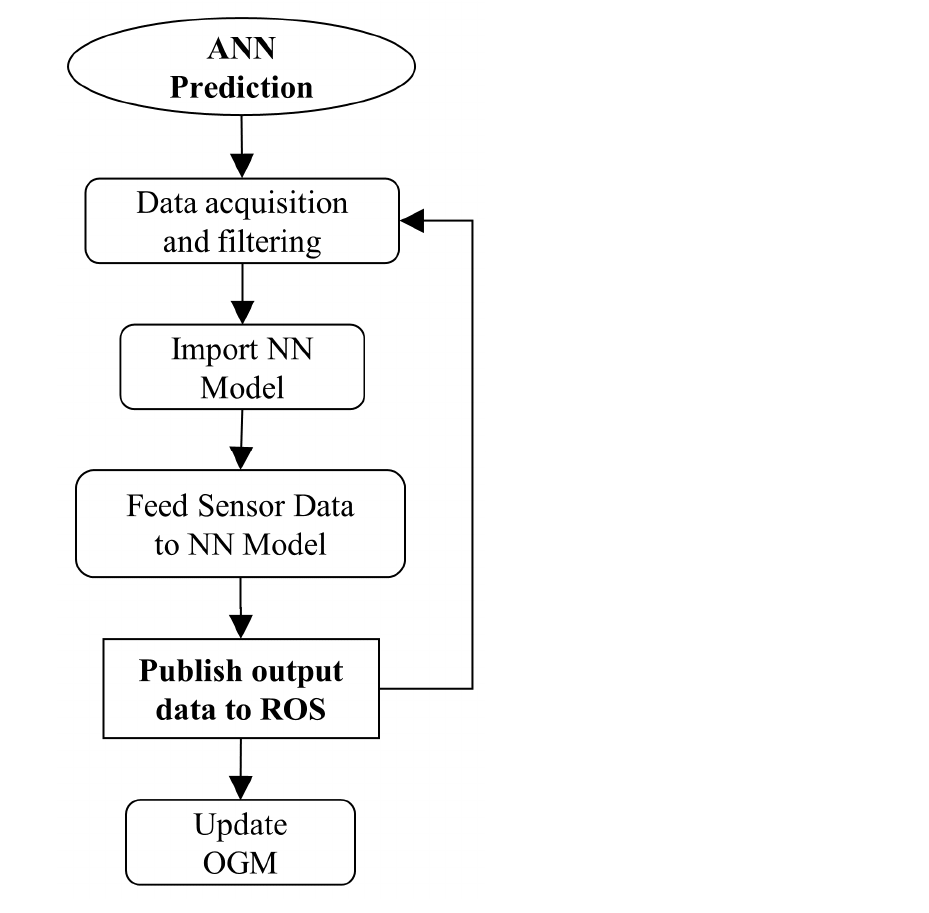
Figure 12. The neural network prediction working principle in which the data is obtained, fed to the NN, the distance output is generated and published into the ROS ecosystem for other services to use. Table 4. Adam Configuration